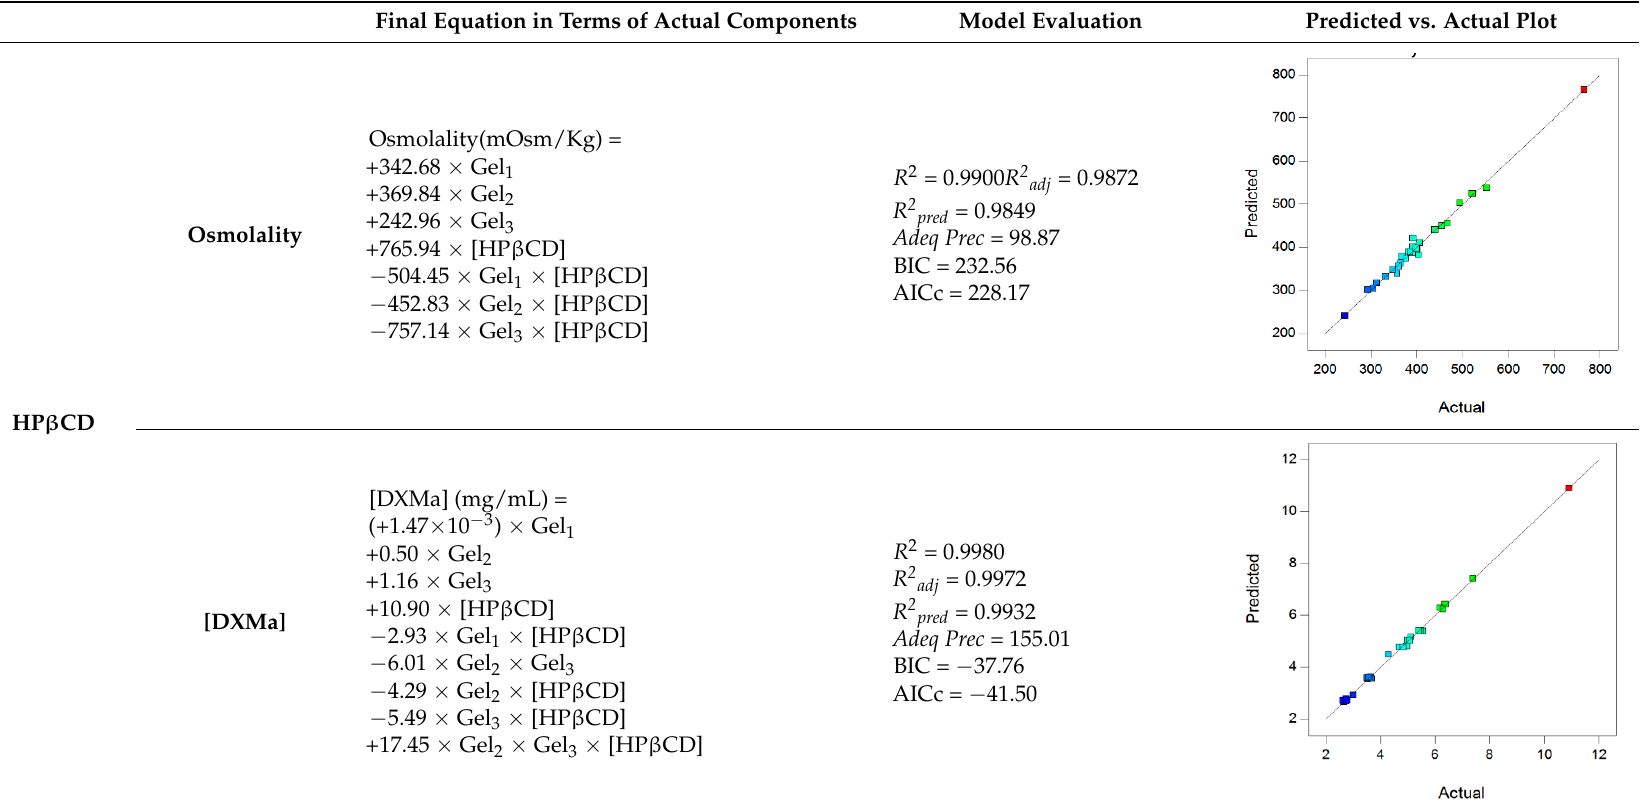
Table 6. Best models containing the best subset of the predictors after backward stepwise selection, overall quality of model fit and the corresponding predicted against actual plot, Gel 1 : CELLUVISC ® , Gel 2 : GEL-LARMES ® and Gel 3 : VISMED ® .